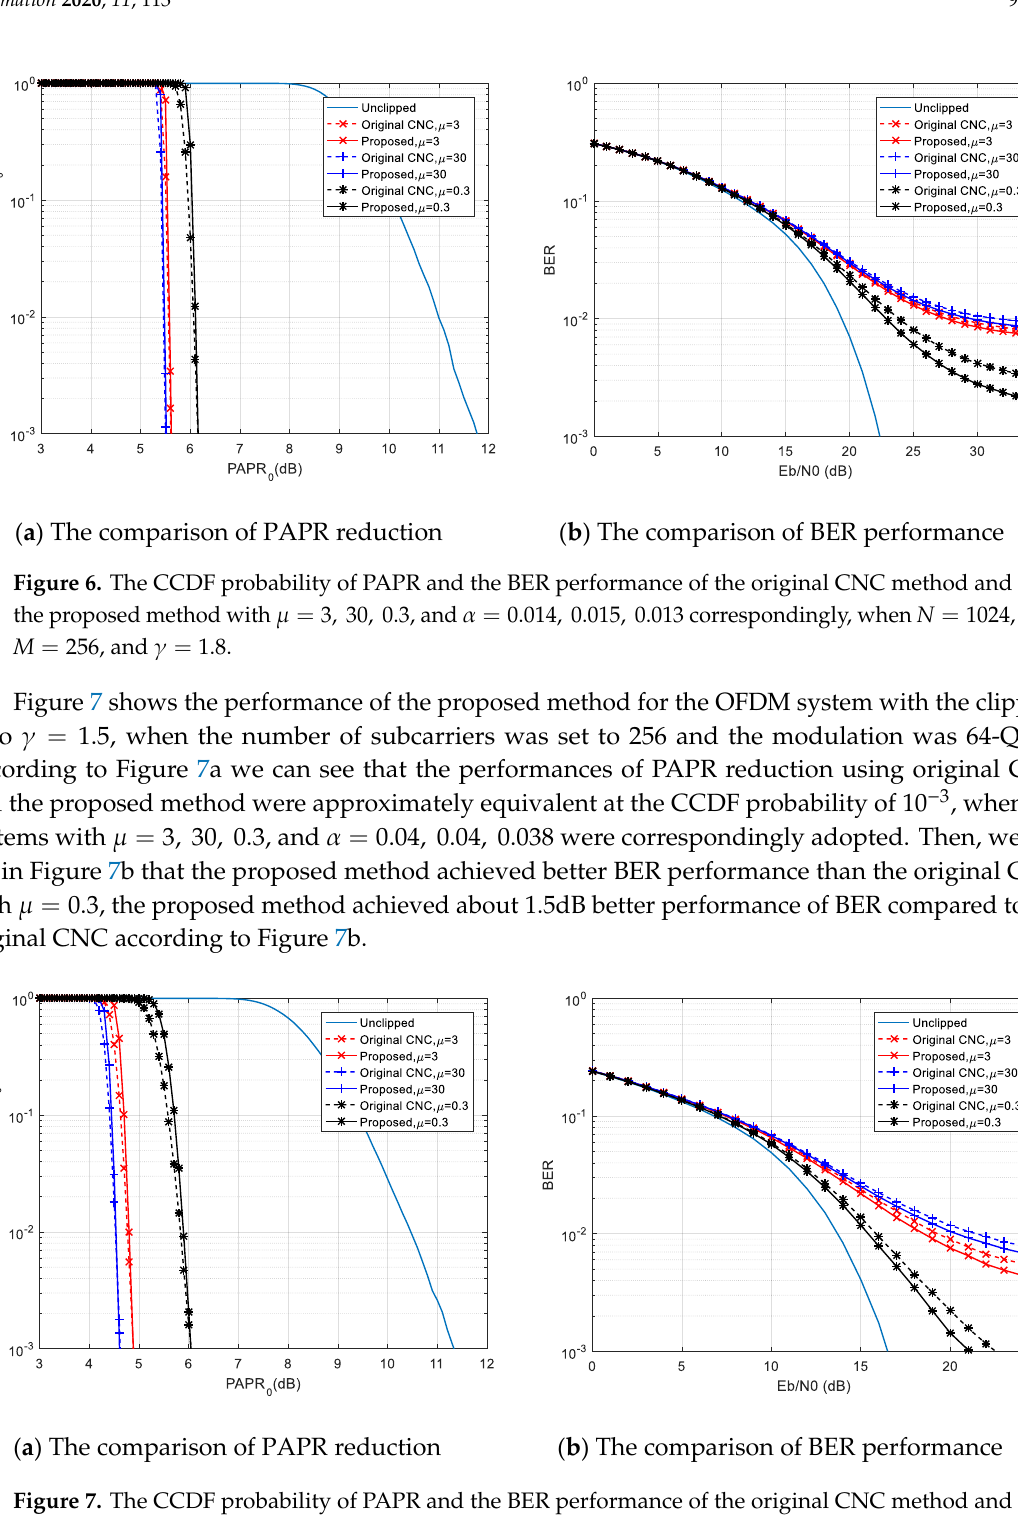
Figure 7. The CCDF probability of PAPR and the BER performance of the original CNC method and the proposed method with µ = 3, 30, 0.3, and α = 0.04, 0.04, 0.038 correspondingly, when N = 256, M = 64, and γ = 1.5.